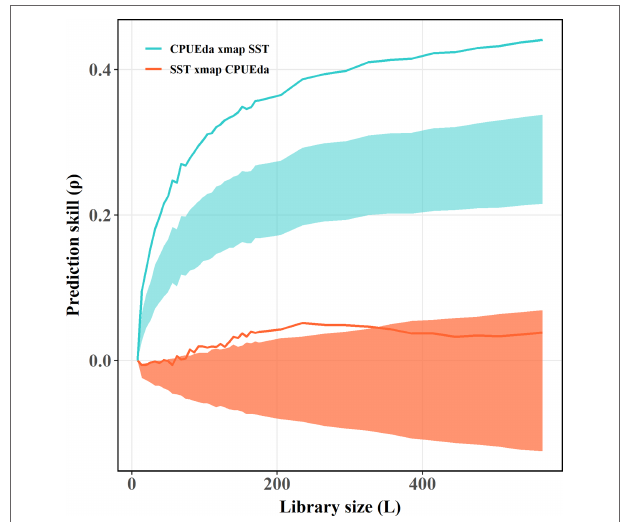
FIGURE 10 | Results of the CCM applied to the nonlinear dynamics of CPUEda and SST. The blue lake and bright orange lines indicate the effect of SST on CPUE and the opposite effective direction from CPUE to SST, respectively. The shadows represent the 95th percentile of the results of the CCM for the surrogate data versus the original effect time